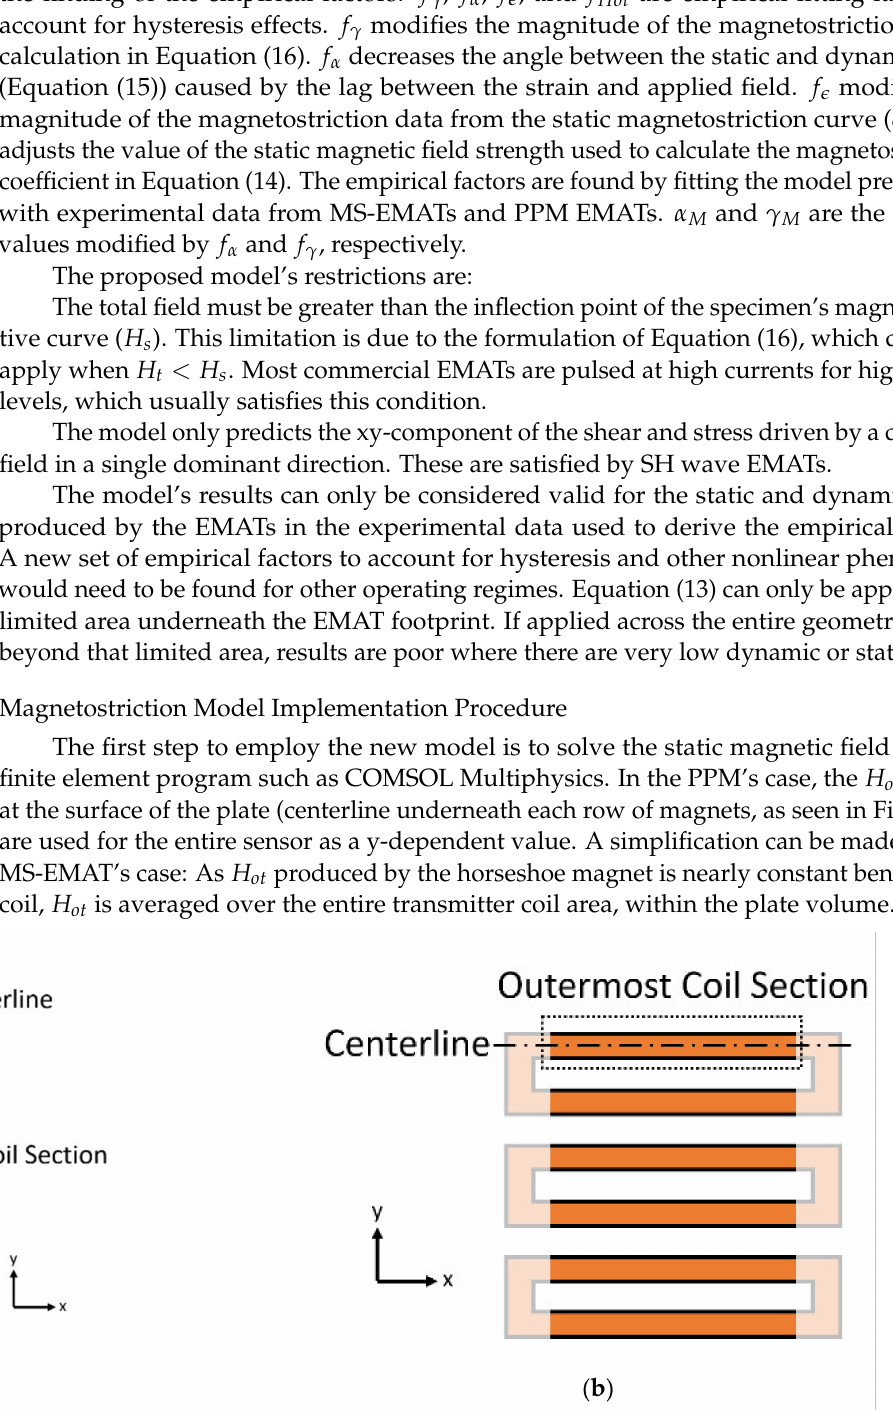
Figure 6. Top View Coil Section Diagram for ( a ) PPM EMAT; ( b )